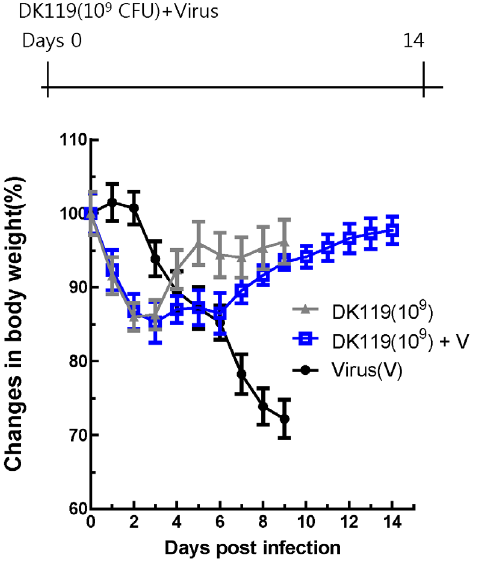
Figure 1. Intranasal co-administration of DK119 (10 9 CFU) and A/PR8 H1N1 virus confers protection. BALB/c mice (n=5 per group) were infected with A/PR8 virus (2.5 LD 50 ) alone or co- administered with DK119 (10 9 CFU per mouse) and A/PR8 H1N1 virus, and body weight changes were monitored daily for 14 days. Virus (V): mice infected with A/PR8 virus, DK119(10 9 ) + V: mice infected with DK119 and A/PR8 H1N1 virus.DK119 (10 9 ): mice treated with DK119 (10 9 CFU per mouse) alone. Bars indicate standard